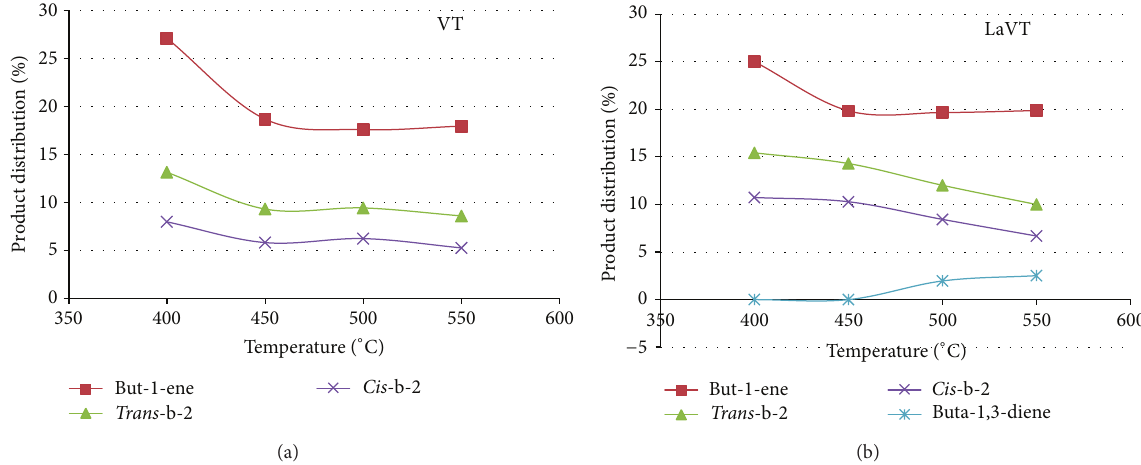
Figure 8: The distribution of alkene’s products with the reaction temperatures.